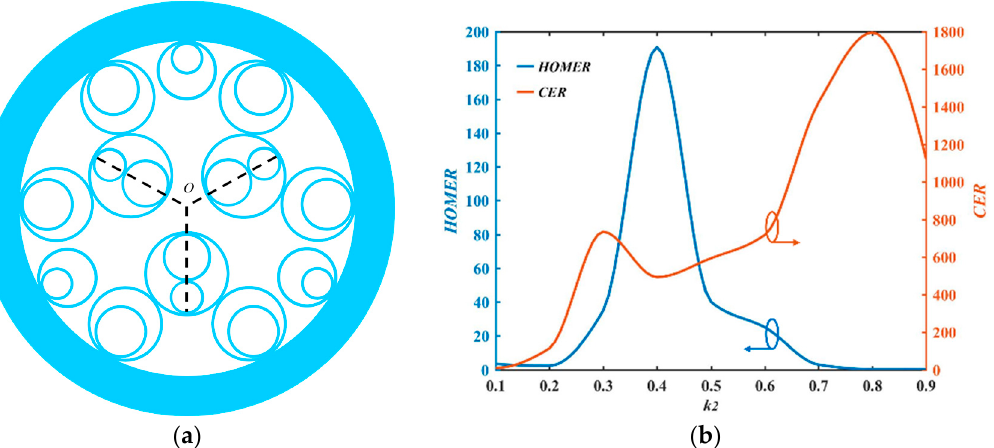
Figure 15. ( a ) The previous structure with the addition of a tube; ( b ) the change in HOMER and CER with k 2 .